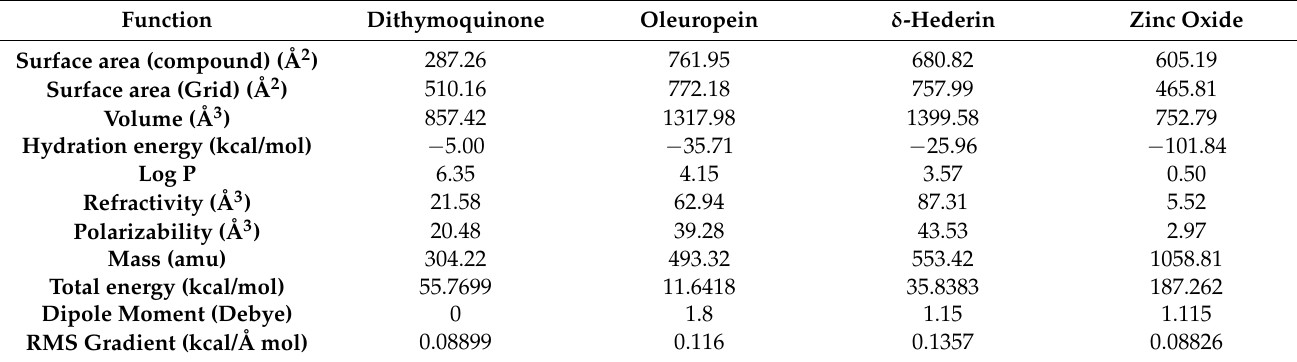
Table 2. QSAR data for optimized compounds.